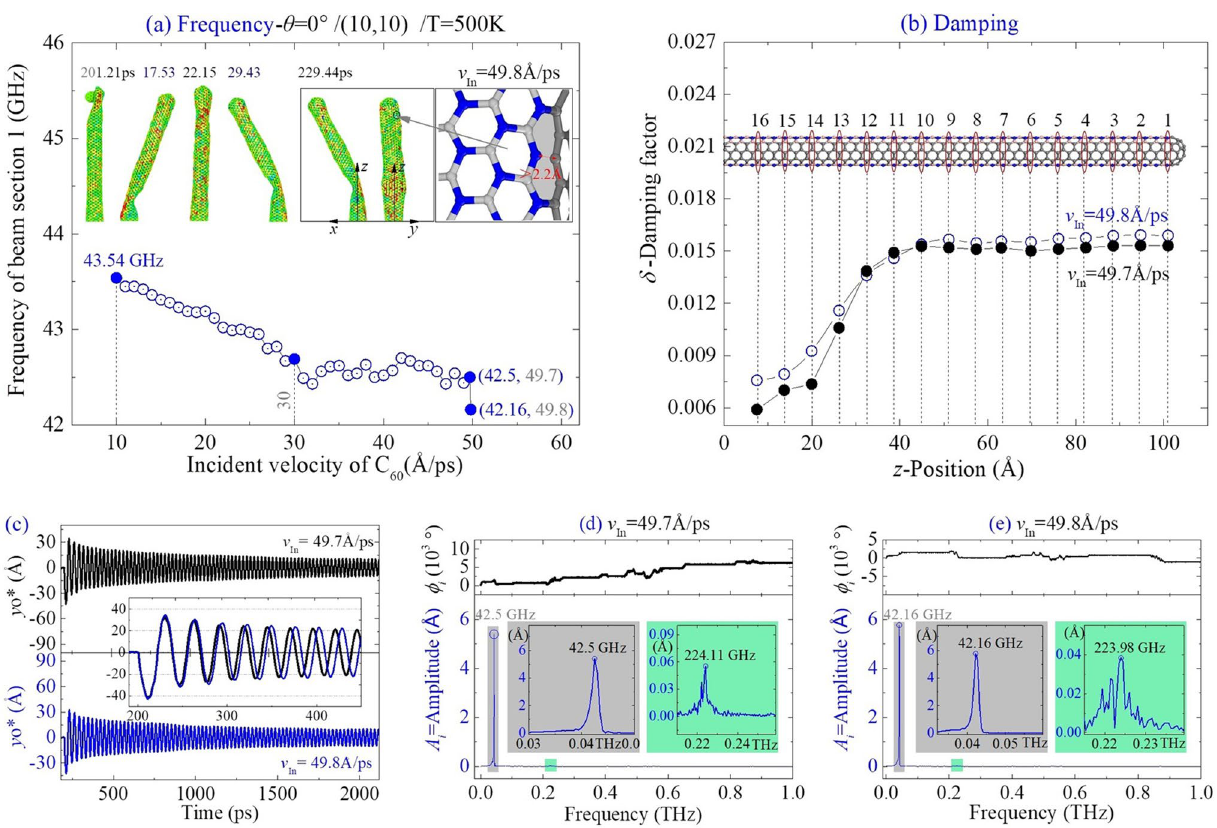
Figure 9. Vibration analysis of (10,10) nanobeam impacted by a high-speed C60 along the path of θ = 0° at 500 K. ( a ) Natural frequencies of the beam impacted by the C60 with different incident velocities. ( b ) Damping factors of beam sections. ( c ) Vibration curves of yo*, and ( d , e ) the FFT